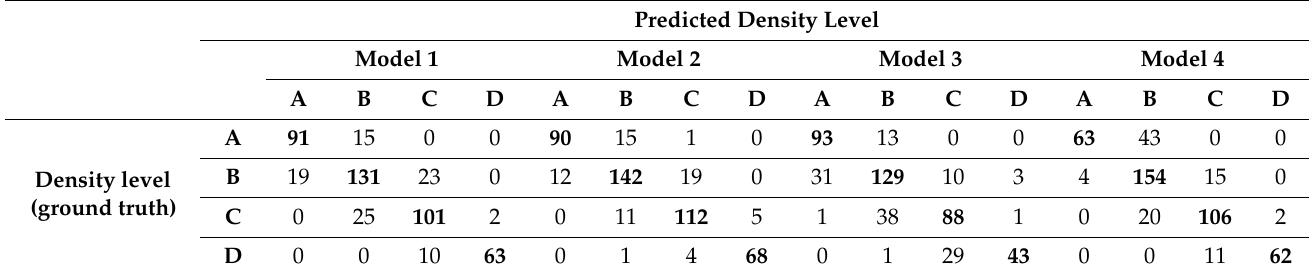
Table 3. Confusion matrices of the “real-world” dataset compared to the assessment of the radiologist as the ground-truth. Numbers in bold highlight the correctly assessed images.